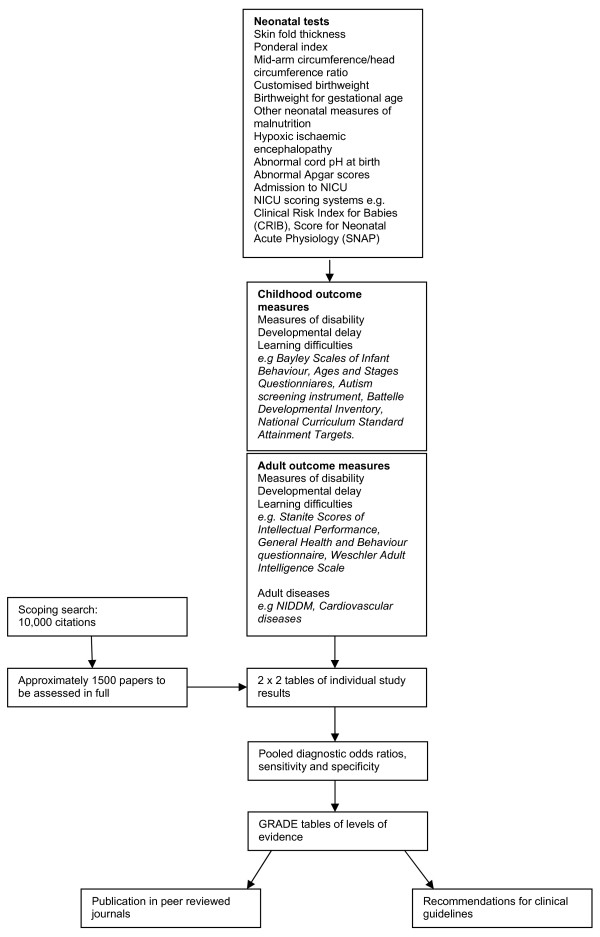
Flow diagram to illustrate neonatal tests and outcomes to be examined in systematic reviews.